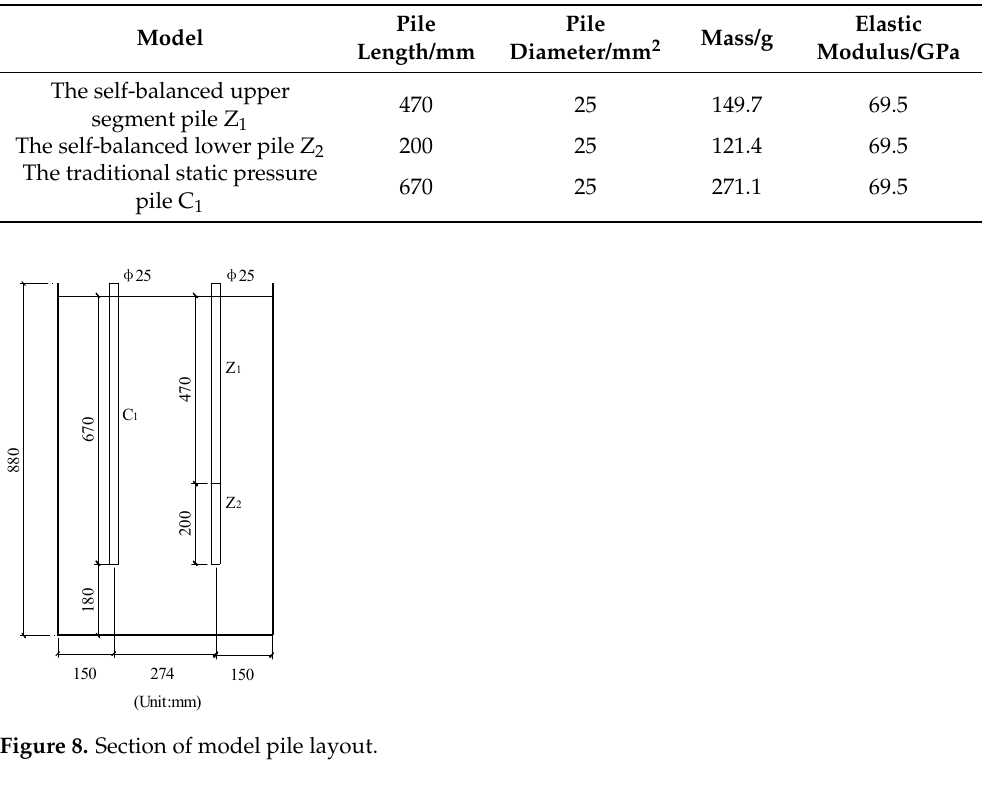
(Unit:mm) Figure 8. Section of model pile layout.